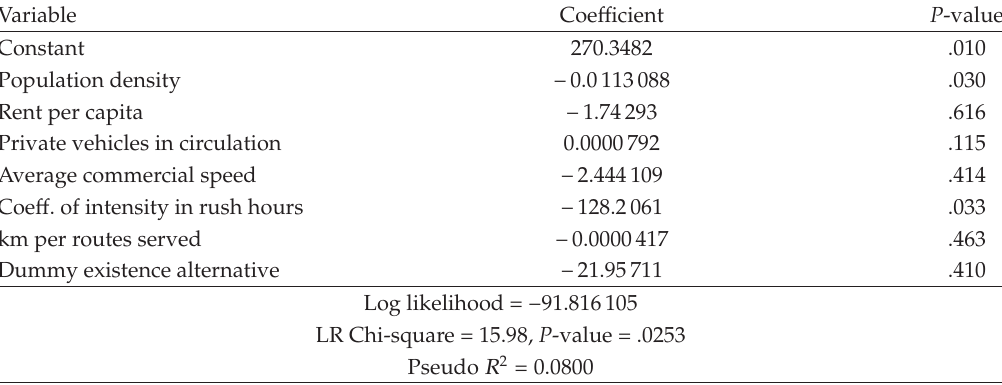
Table 5: Regression of the BCC e ffi ciency index on the external circumstances.